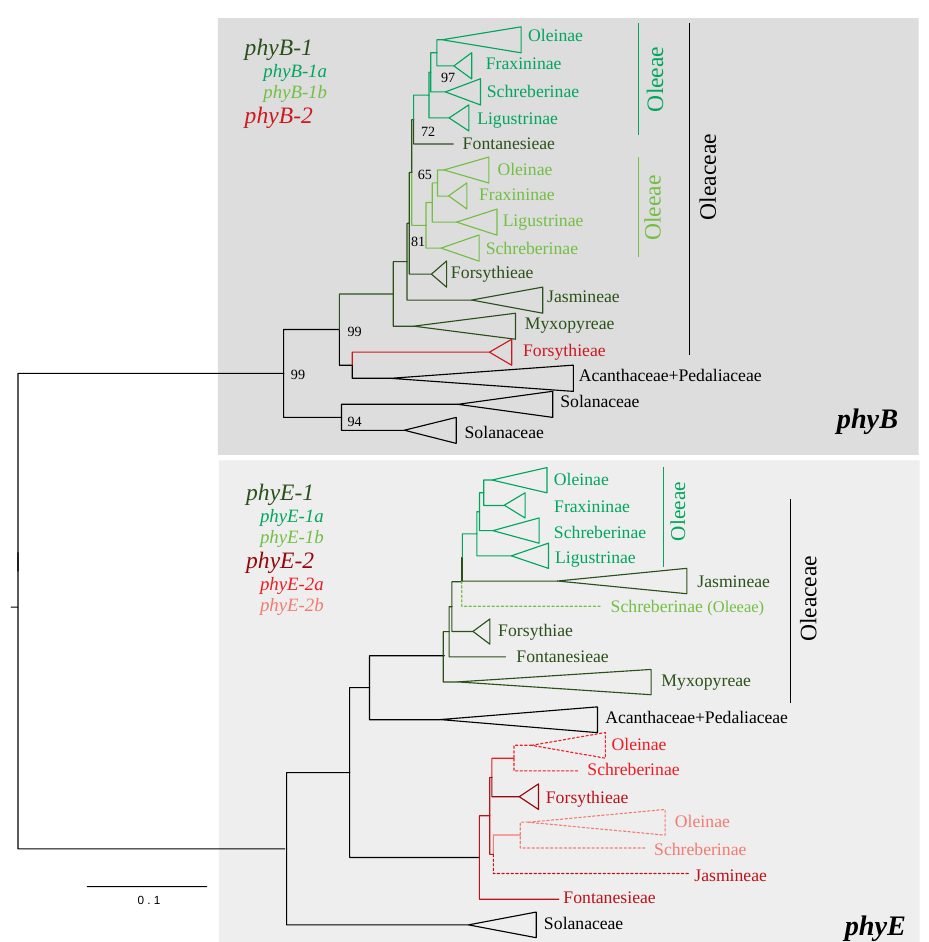
Figure 4. Reduced representation of the midpoint-rooted maximum likelihood phylogenetic tree of the phy gene family in Oleaceae. Only ultrafast bootstrap (UFB) values inferior to 100 are indicated on nodes. Putative pseudogenes are denoted by dashed